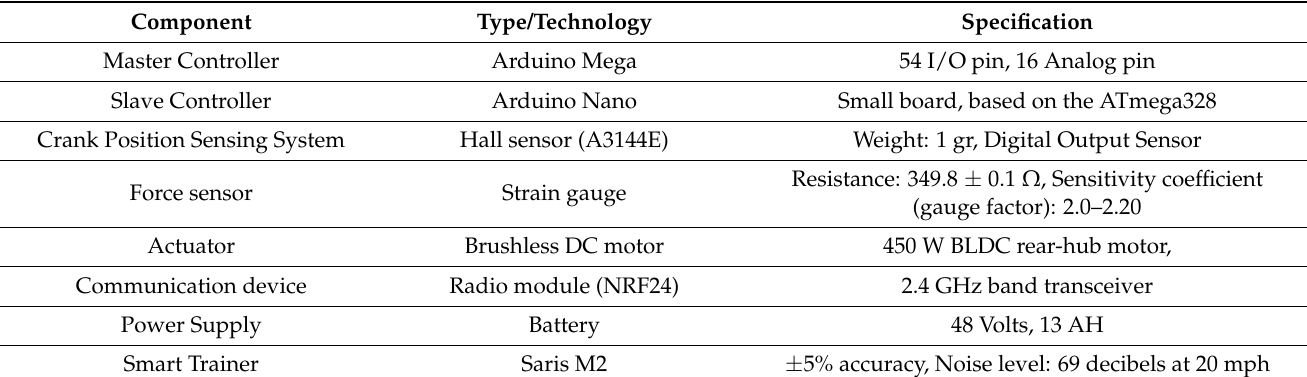
Table 1. The main components of the APAD